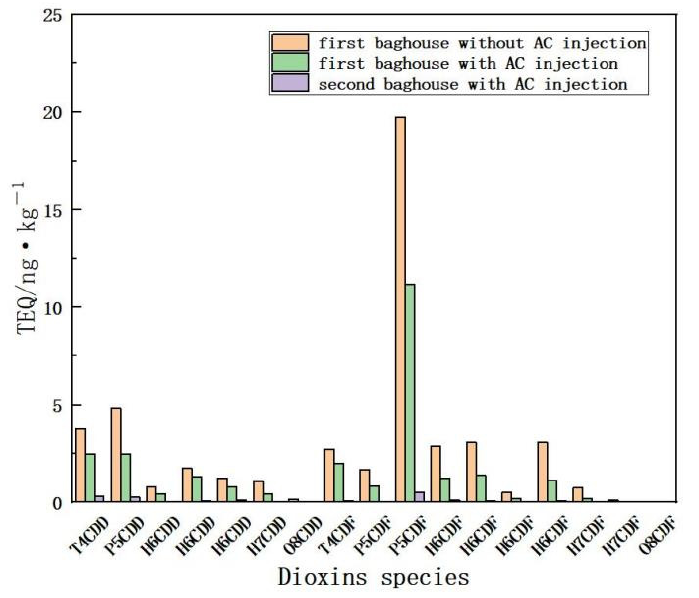
Figure 3. A total of 17 PCDD/Fs TEQ in fly ash: first baghouse without activated carbon injection, first baghouse with activated carbon injection and second baghouse with activated carbon injection.